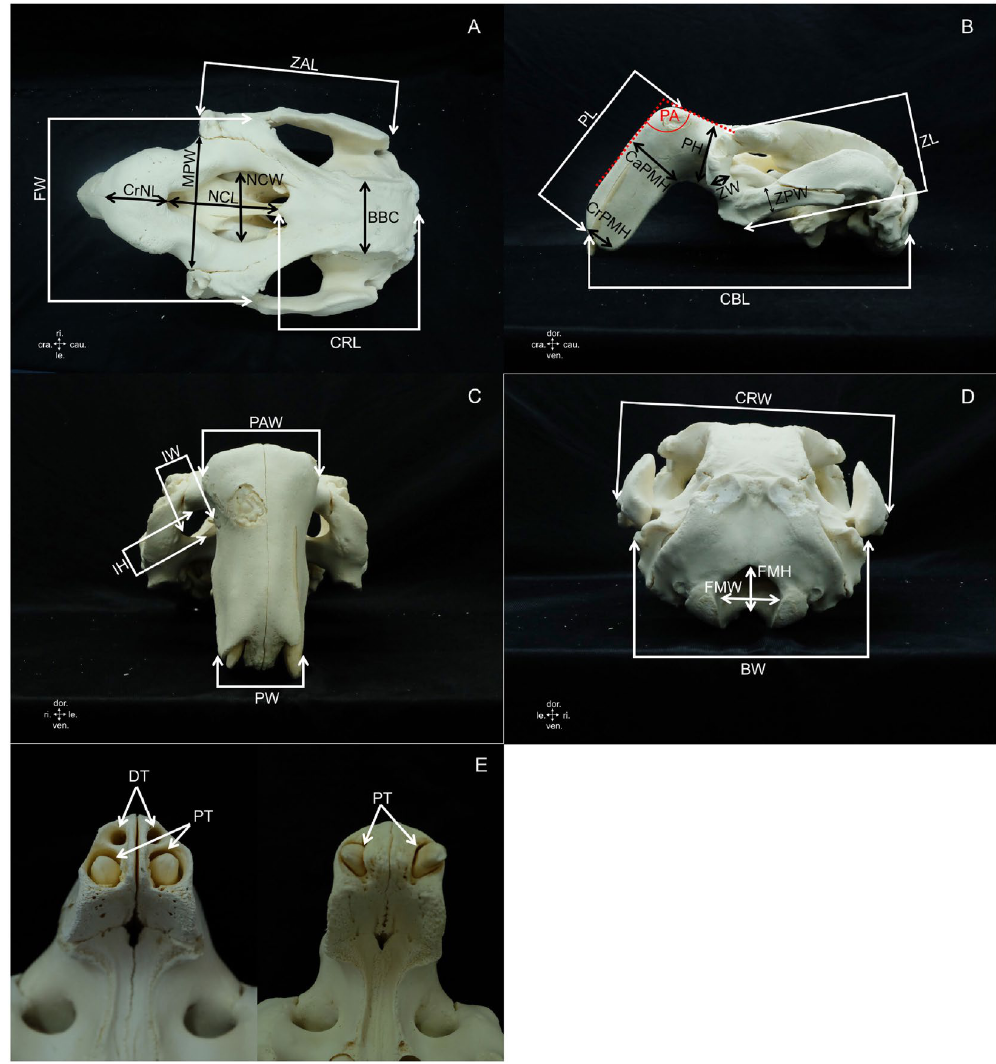
Figure 1. Landmarks for measurements taken from the dugong cranium (see description of measurements in Table 1). Figure 1E, shows a cranium presenting empty sockets of deciduous tusks (DT) and permanent tusks (PT) compared with a cranium presenting only permanent tusks. (cra. = cranial, cau. = caudal, dor. = dorsal, le. = left, ri. = right, ven. =